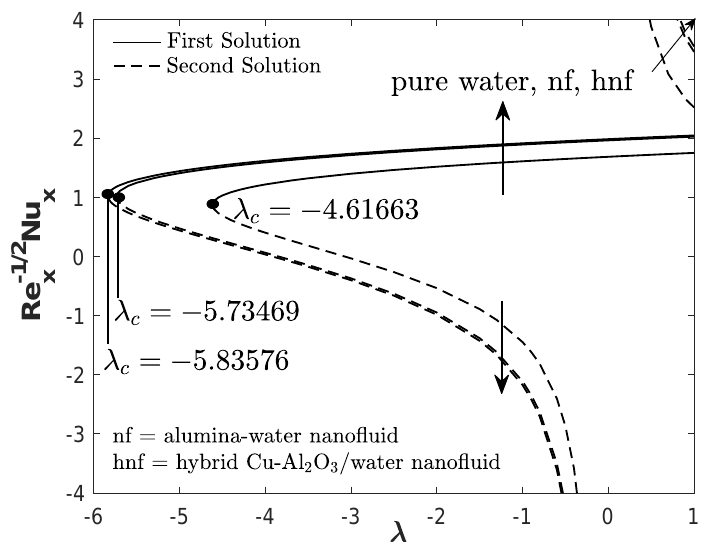
Figure 4. Re x − 1/2 Nu x towards λ for hybrid nanofluid ( φ 1 = 0.1, φ 2 = 0.005 ) , alumina-water nanofluid = 0.1, φ = 0 ) , and pure water ( φ ( φ 2 1